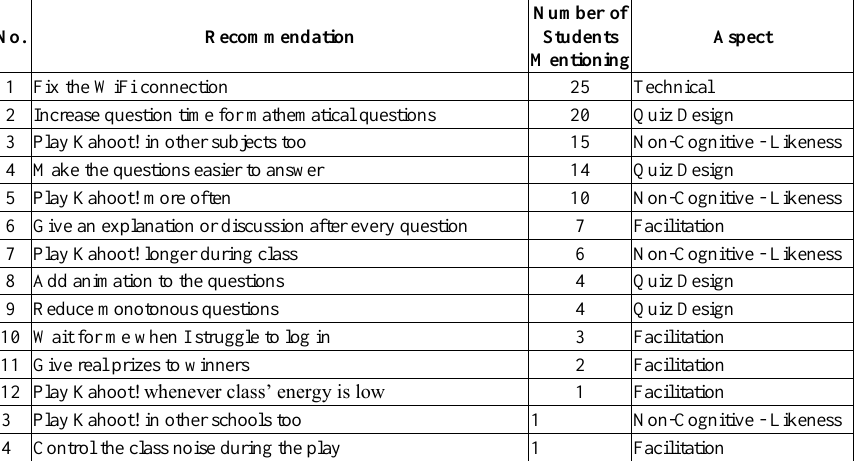
Table 9. Questionnaire Result, Part 3, Question